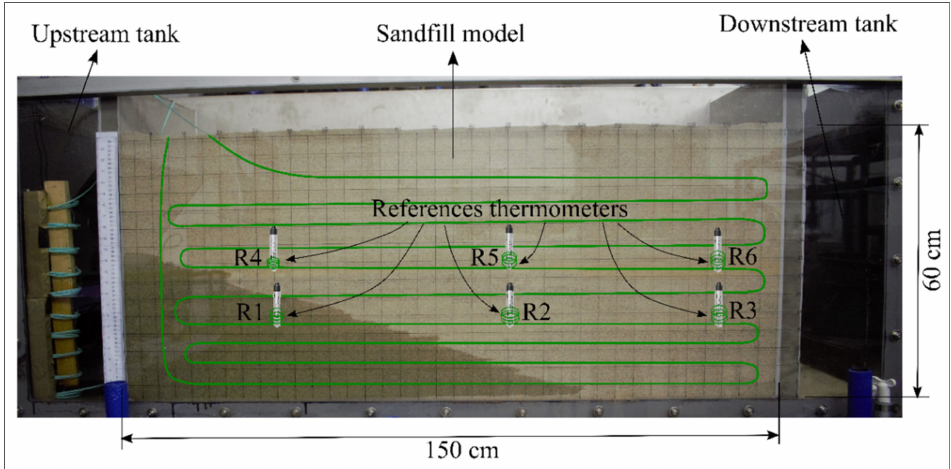
Figure 3. Scheme of temperature sensors and optical fiber arrangement within the